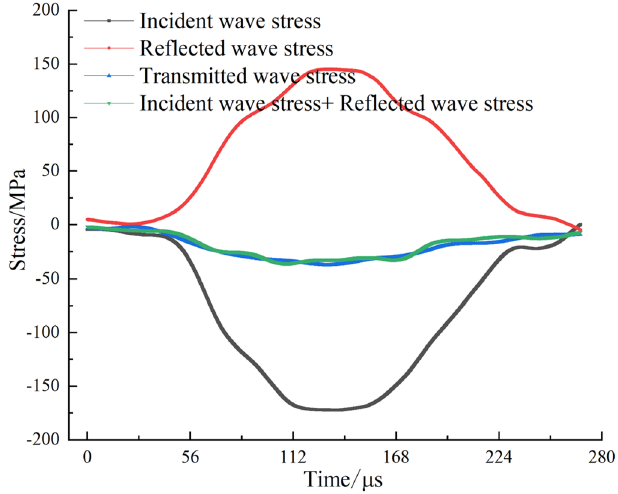
Figure 4. Verification of dynamic stress balance for a typical